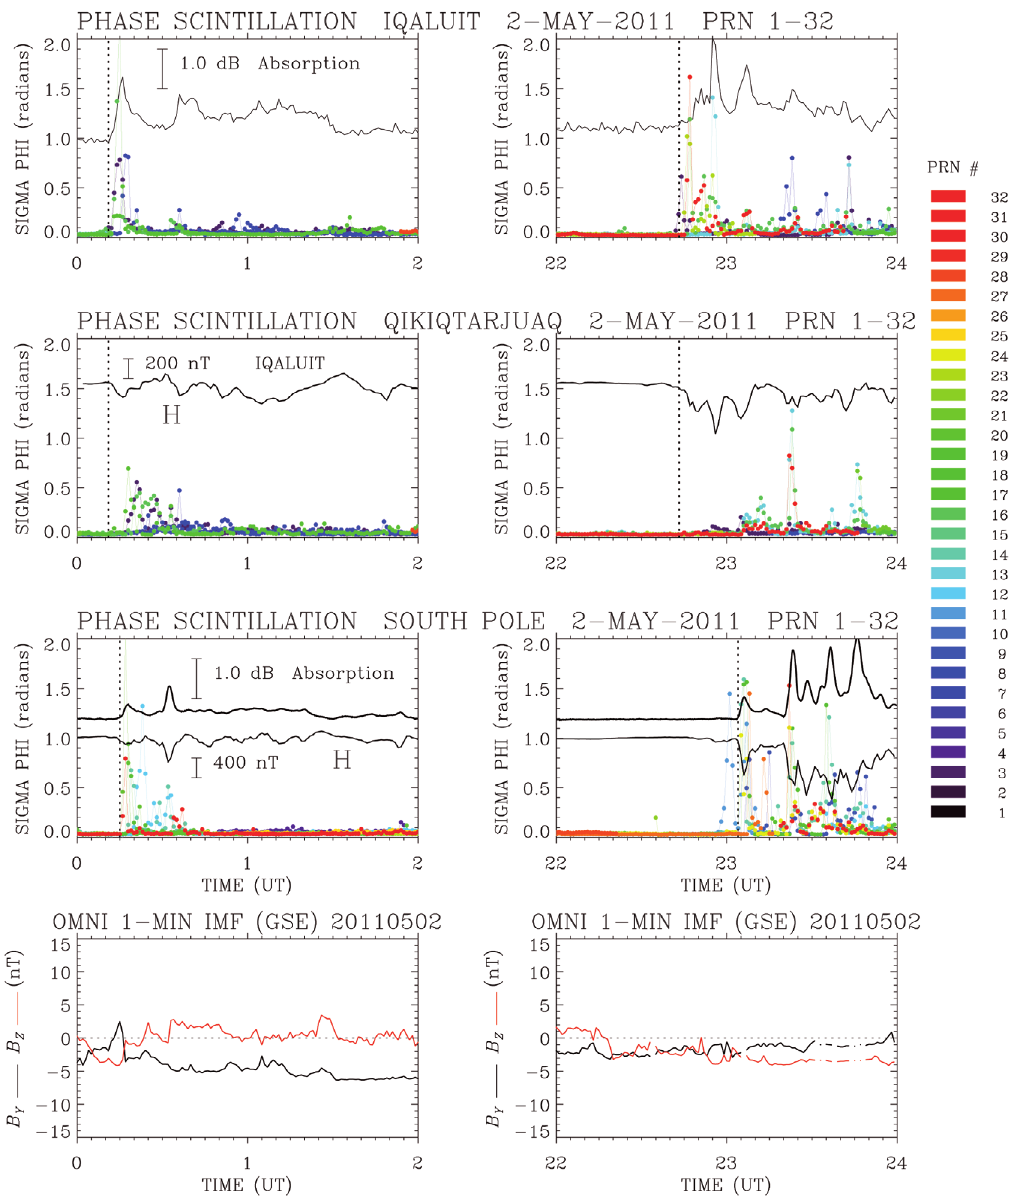
Figure 9. The phase scintillation index v U observed at elevations above 30° on May 2, 2011. The riometer absorption and the H components of the ground magnetic field measured at IQA and SP are superposed in the scintillation panels. The IMF B tom